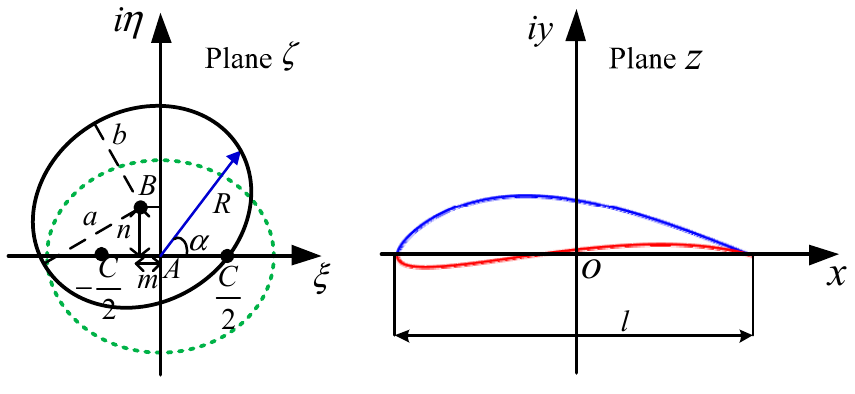
Figure 3. Ellipse transformation model. The ellipse is moved a certain distance along the real axis, and the airfoil with a variable relative thickness position is obtained by the Joukowski transformation. The relationship between the major axis and the minor axis of the ellipse determines whether the relative thickness position is close to the leading edge or the trailing edge. Thus, a symmetric airfoil with different relative thickness positions can be obtained by moving the rotating ellipse for a certain distance along the imaginary axis, and the airfoil with a variable relative camber position can be obtained through the Joukowski